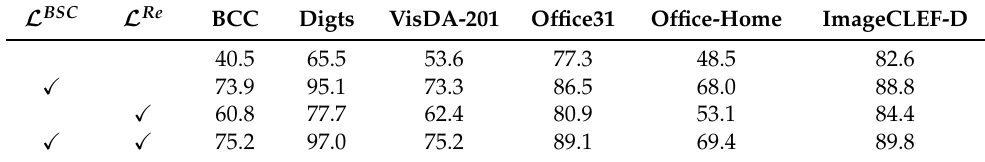
Table 7. The results of the ablation experiment using the average accuracy as a reference. L BSC L Re BCC Digts VisDA-201 Office31